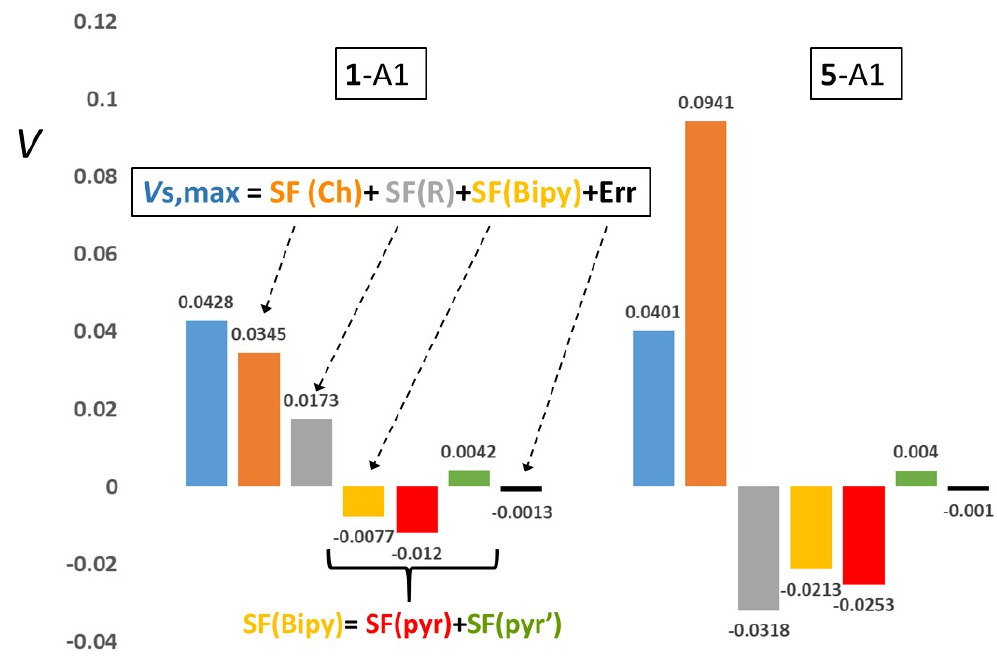
Figure 5. V S , max (au) Source Function (SF) decomposition in two exemplar σ-hole cases (see Tables 4 and 5